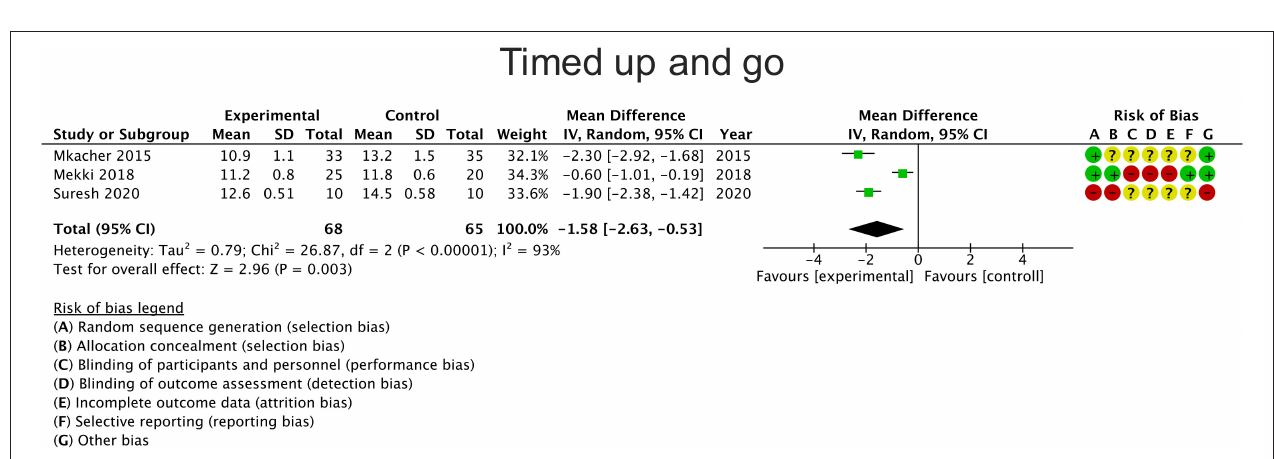
FIGURE 3 | Effects of rehabilitation interventions on the Test timed up and go. Each study considered in the meta-analysis corresponds to a point estimate, which is bounded by a 95% CI.